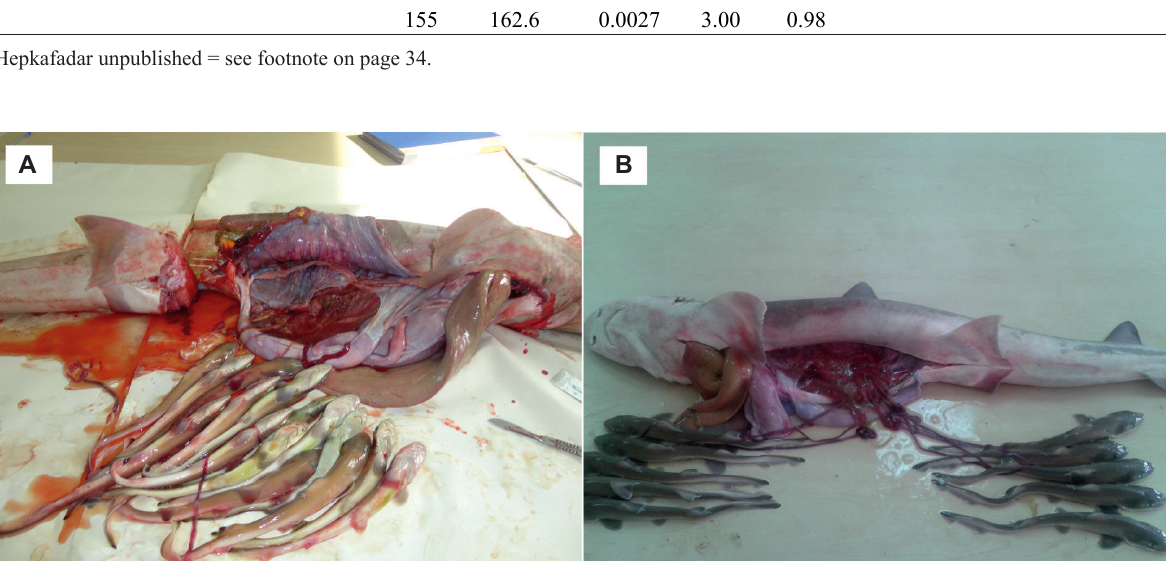
Fig. 12. Examples of dissected pregnant females of Mustelus mustelus caught in January 2014 ( A ) and February 2014 ( B ) from the Gulf of Iskenderun, north-eastern Mediterranean Sea